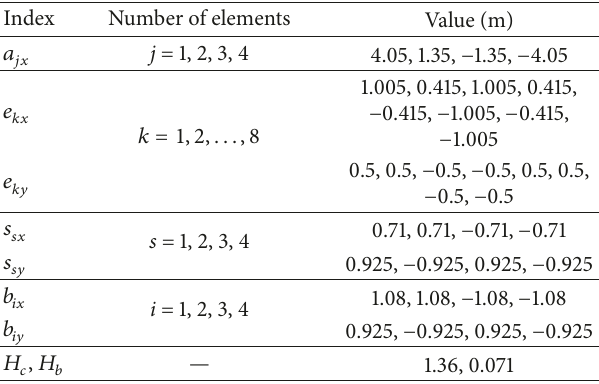
Table 1: Geometric properties of the UTM vehicle model.